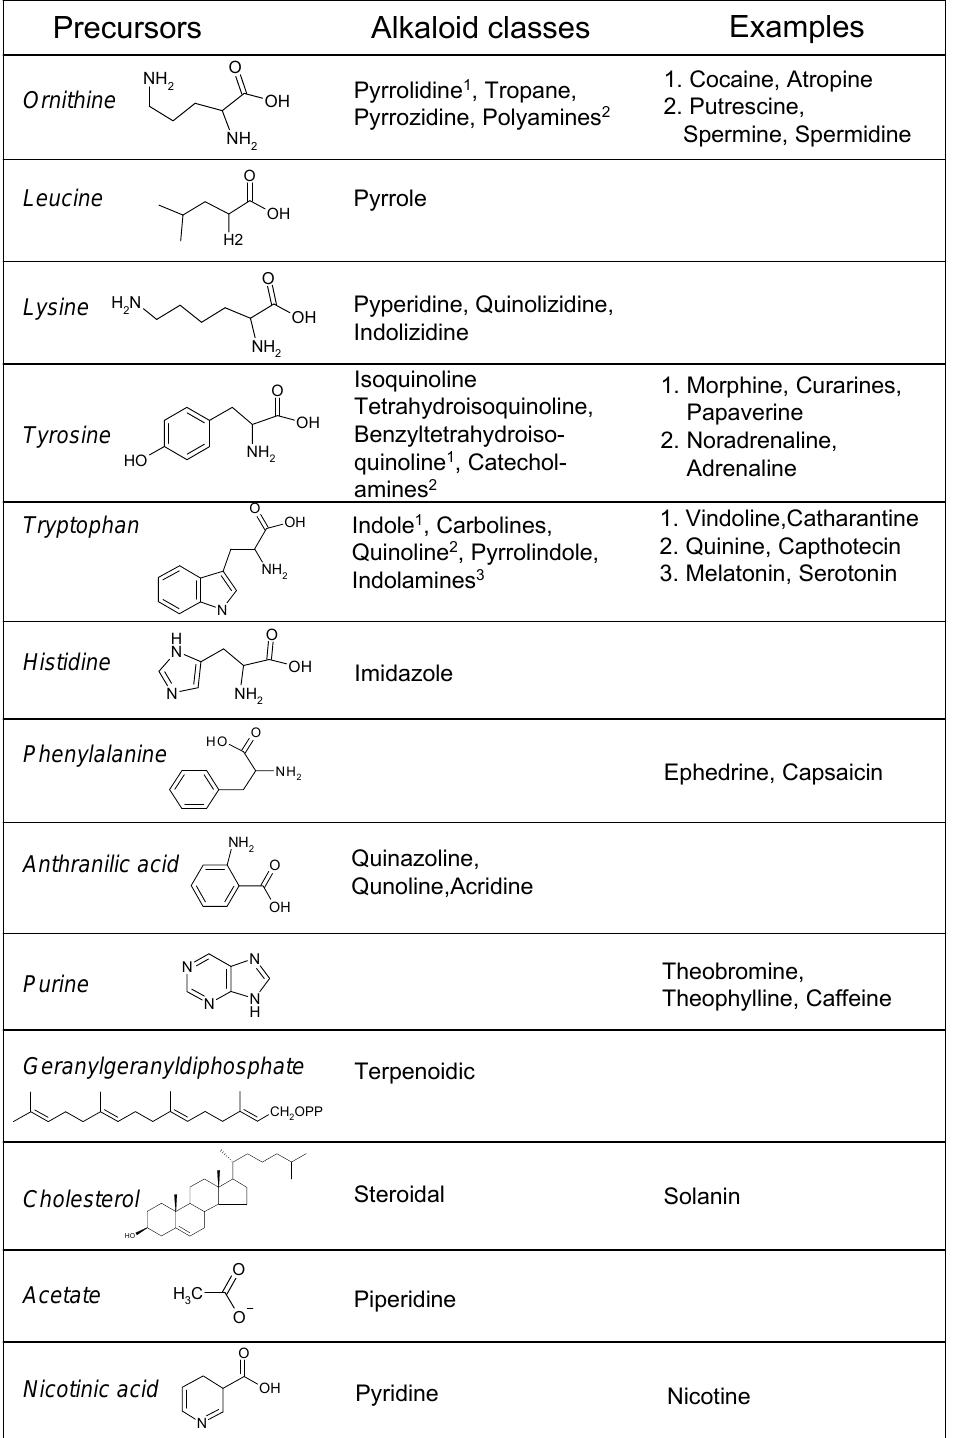
Figure 2. Main classes of alkaloid precursors and derivatives (the example number refers to the corresponding alkaloid